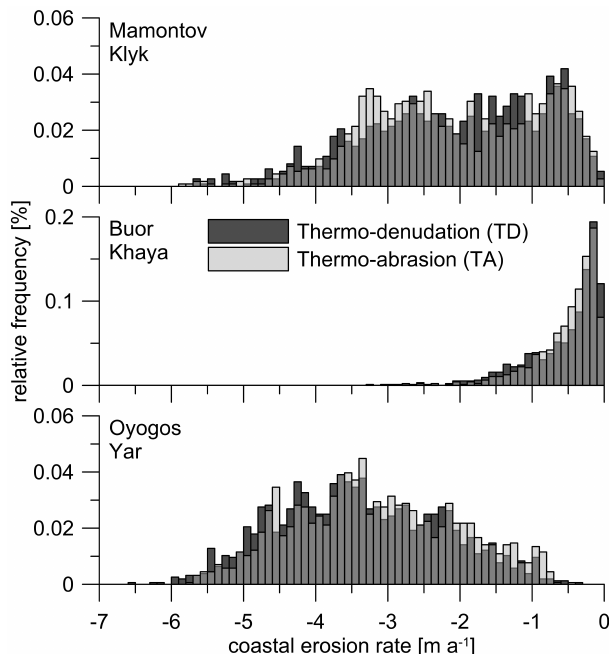
Fig. 3. Site specific histograms of long-term mean annual coastal erosion rates (ma − 1 ) obtained from coastal transect data, seperated into thermo-denudation (TD) and thermo-abrasion (TA) rates.